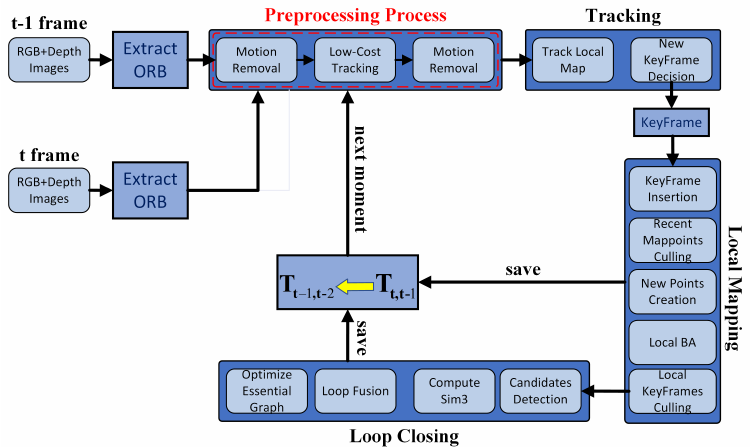
Figure 1. The DGFlow-SLAM frame proposed in this paper. The red dashed box means the pre- processing process part. The yellow arrow indicates that the optimized transformation matrix T t , t − 1 at the current moment is saved and used as T t − 1, t − 2 at the next moment to speed up the preprocessing